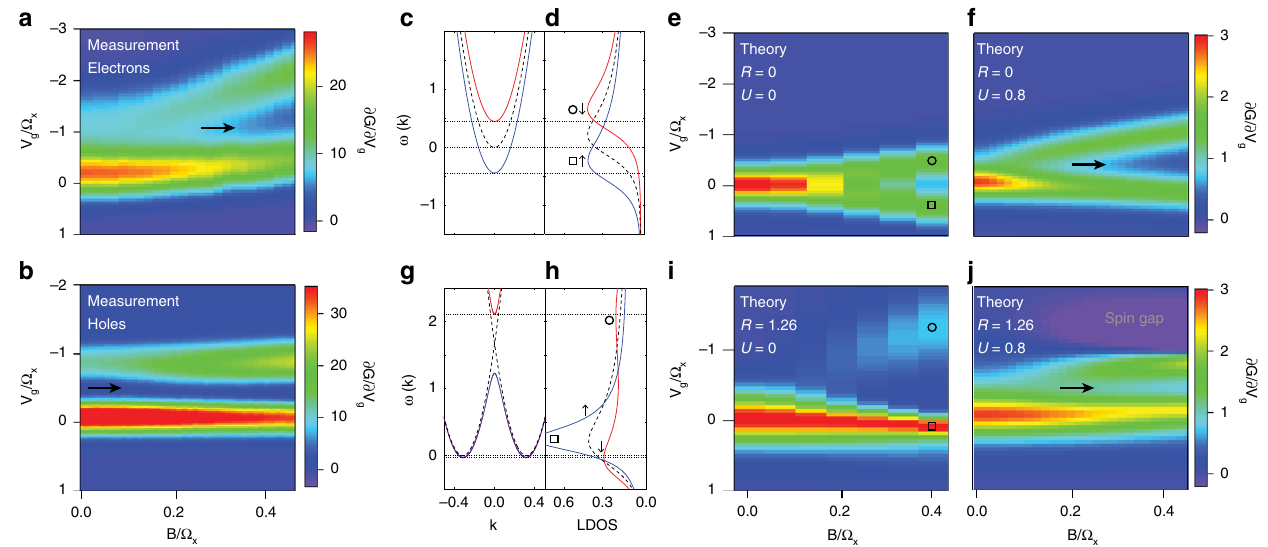
Fig. 3 Comparison of measured 1D transconductance to tight-binding numerical calculations. a Close up of the measured transconductance of the fi rst 1D subband in the electron QPC (the region in the white dashed box in Fig. 2a), showing the fi rst 1D electron subband spin-splits in magnetic fi eld. Gate voltage V g and magnetic fi eld B axes are converted to energy and scaled with the QPC constriction curvature parameter Ω x for comparison with theory. b Close up of the measured transconductance from hole QPC 1 (the region in the white dashed box in Fig. 2b), showing the transconductance of the fi rst 1D hole subband is clearly different to electron QPCs, and does not split in magnetic fi eld. c Calculated dispersion relation of the fi rst spin-resolved subband (spin-up shown in blue, spin-down in red) in B > 0. The vertical axis is energy ω and the horizontal axis is wavevector k . The B = 0 dispersion relation is indicated by the black dotted line. d The local density of states (LDOS) calculated from the dispersion relation shown in ( c ), plotted against energy E . Again the LDOS is shown for each resolved spin-species in blue and red (indicated by the up and down arrows), and the black dotted line is the LDOS in zero magnetic fi eld. e Calculated transconductance colour map of the fi rst 1D subband with no Rashba SOI ( R = 0) and no on-site Coulomb interactions ( U = 0). The circle and square markers correspond to the two spin-resolved peaks in the LDOS in ( d ). f Calculated transconductance colour map of the fi rst 1D subband with no Rashba SOI and fi nite on-site Coulomb interactions U = 0.8. The 0.7 anomaly is indicated by the black arrow. g Calculated dispersion relation of the fi rst subband with spin-mixing in magnetic fi eld. The pure spin-states are indicated by the red and blue regions in the dispersion relation at k = 0. The spin-mixed states are indicated by the purple regions away from k = 0. h The LDOS for the dispersion model shown in ( g ). For B > 0, the spin- up species in blue forms a single large peak, while the spin-down species in red forms two smaller peaks, with the peak at low energy emerging because of spin-mixing. i Calculated transconductance colour map of the fi rst 1D subband with Rashba SOI R = 1.26 and zero on-site Coulomb interactions U = 0. Circle and square markers correspond to the LDOS peaks indicated by the same markers in panel ( h ). j Calculated transconductance colour map of the fi rst 1D subband with Rashba SOI magnitude R = Fig. 1f – h, indicating that the g -factor cannot be zero. We also cannot attribute this behaviour to peculiarities of the in-plane g - factor anisotropy; even if B is applied out-of-plane, where the g - factor is an order of magnitude larger than the in-plane g -factors, the fi rst subband shows no spin-splitting of transconductance up to 0.9 T, whereas the higher subbands have already entered the quantum Hall regime (see Supplementary Information Section 3).